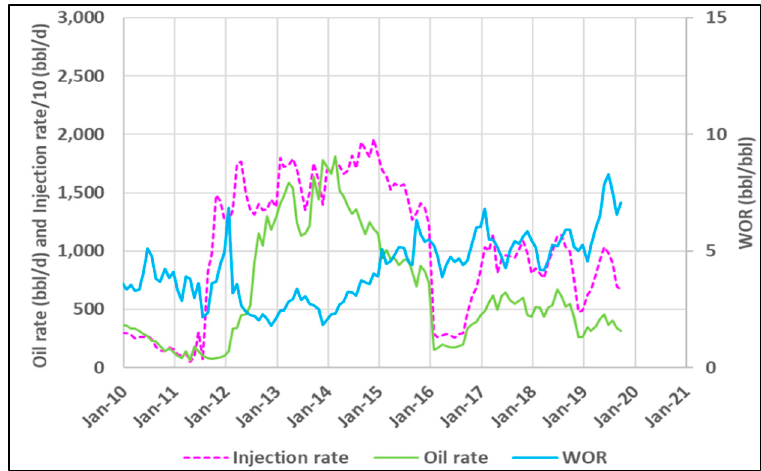
Figure 6. Technological data of ASP flooding implementation in Mooney field [65].